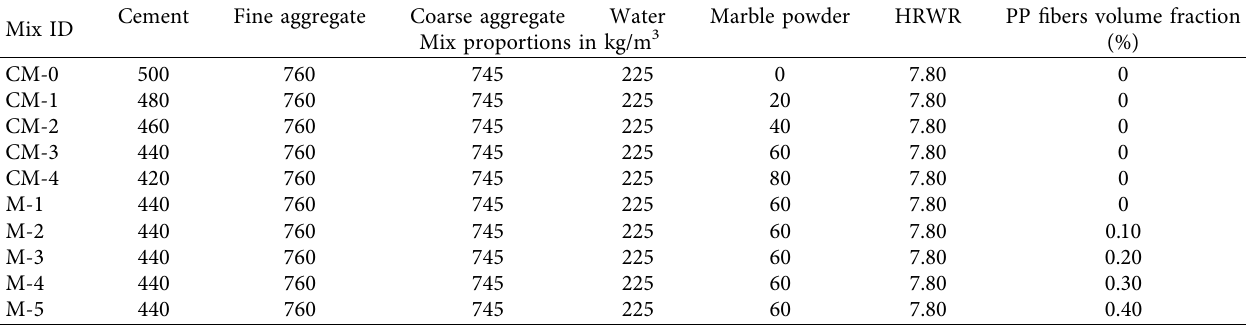
Figure 1: (a) Marble powder; (b) polypropylene fibers. Table 3: Concrete mix proportioning.